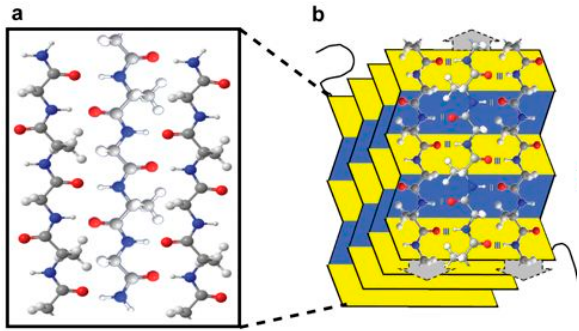
Figure 10. An illustration of ( a ) a three chain silk sequence composed of carbon (gray), nitrogen (blue), oxygen (red) and hydrogen (white); ( b ) 3-dimensional β -sheet of silk. Reproduced with permission from [100].